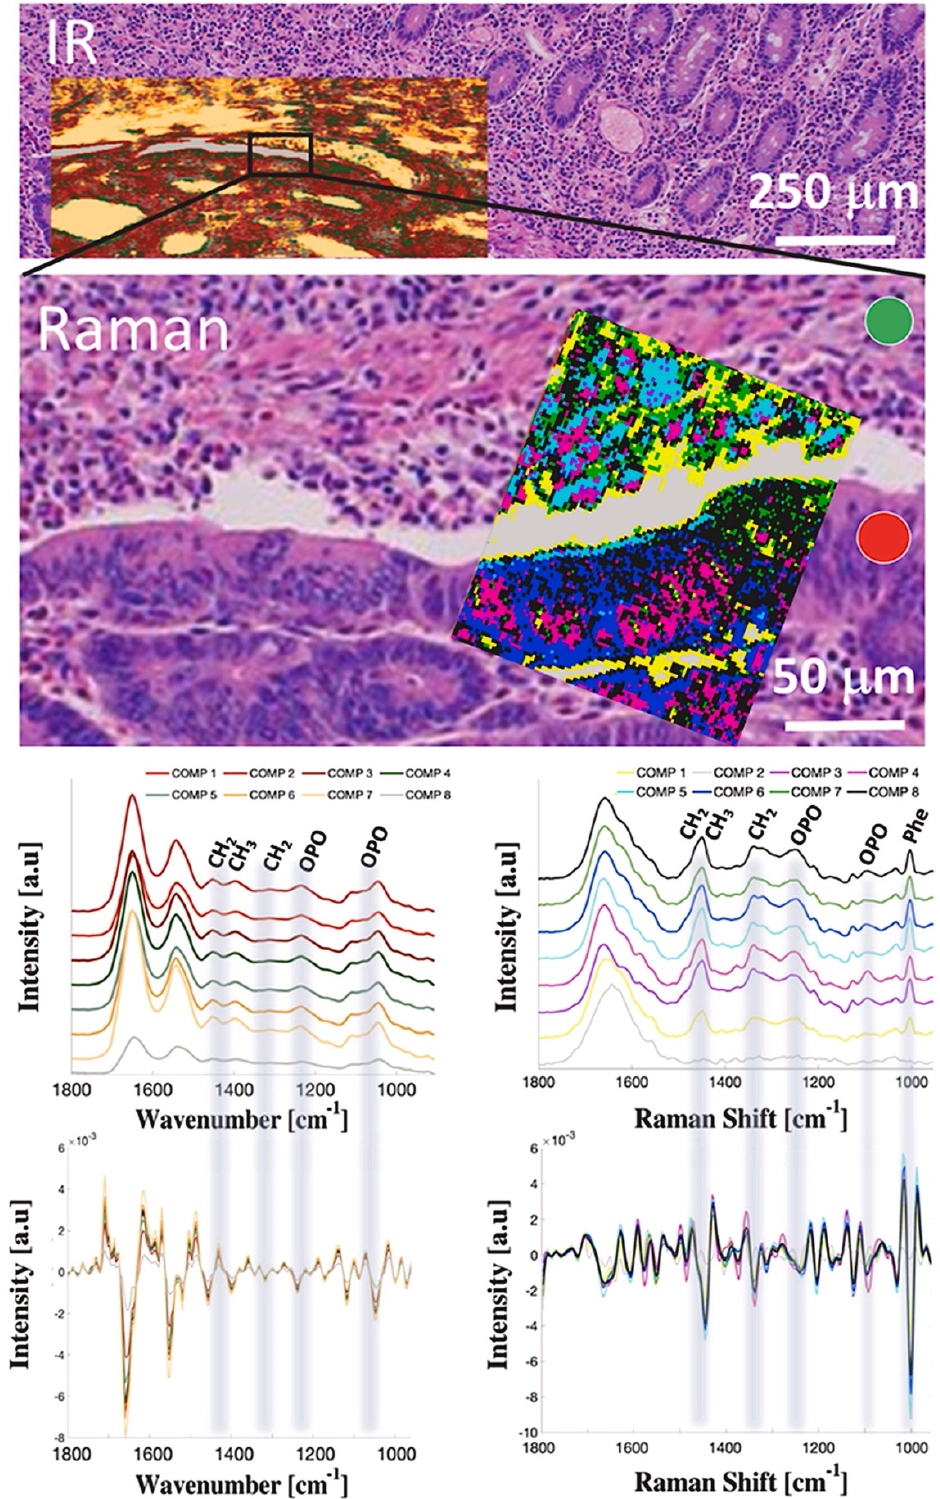
Figure 5. Spectroscopic mapping of ampullary adenocarcinoma: A hematoxylin-eosin slide image of ampullary cancer tissue with superimposed FTIR and Raman hyperspectral maps treated with hierarchical cluster analysis, and averaged spectra with corresponding second derivatives from each cluster; spectroscopic maps cover both cancerous (red circle) and noncancerous—stroma (green circle) tissue fragments. Reproduced with permission from Szymonski et al., Clinical Spectroscopy, published by Elsevier B.V, 2021 [251]. FTIR, Fourier transform infrared spectroscopy.